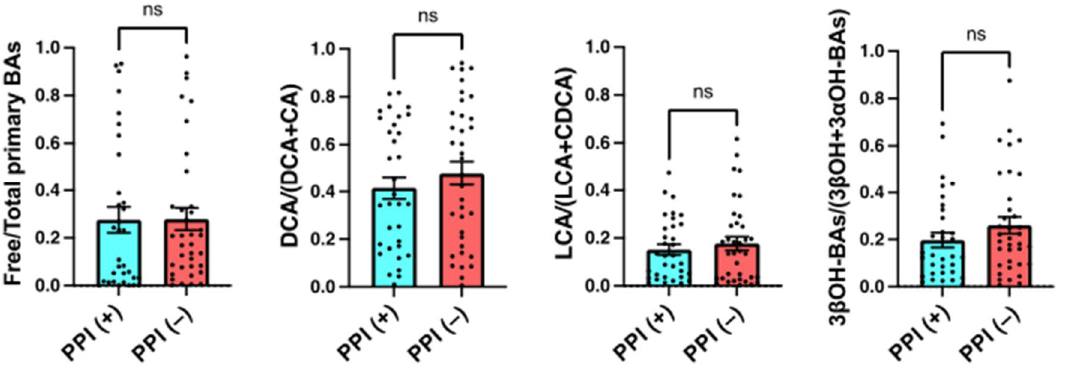
Figure 5. Effects of proton pump inhibitor use on serum BA markers. Serum samples were obtained on admission (prior to antibiotic use and CDI onset). PPI (+), patients using proton pump inhibitors ( n = 33); PPI (-), patients not using proton pump inhibitors ( n = 36). Each column and error bar represents the mean and SEM. Statistical significance was tested by the Mann–Whitney test; ns, not significant.